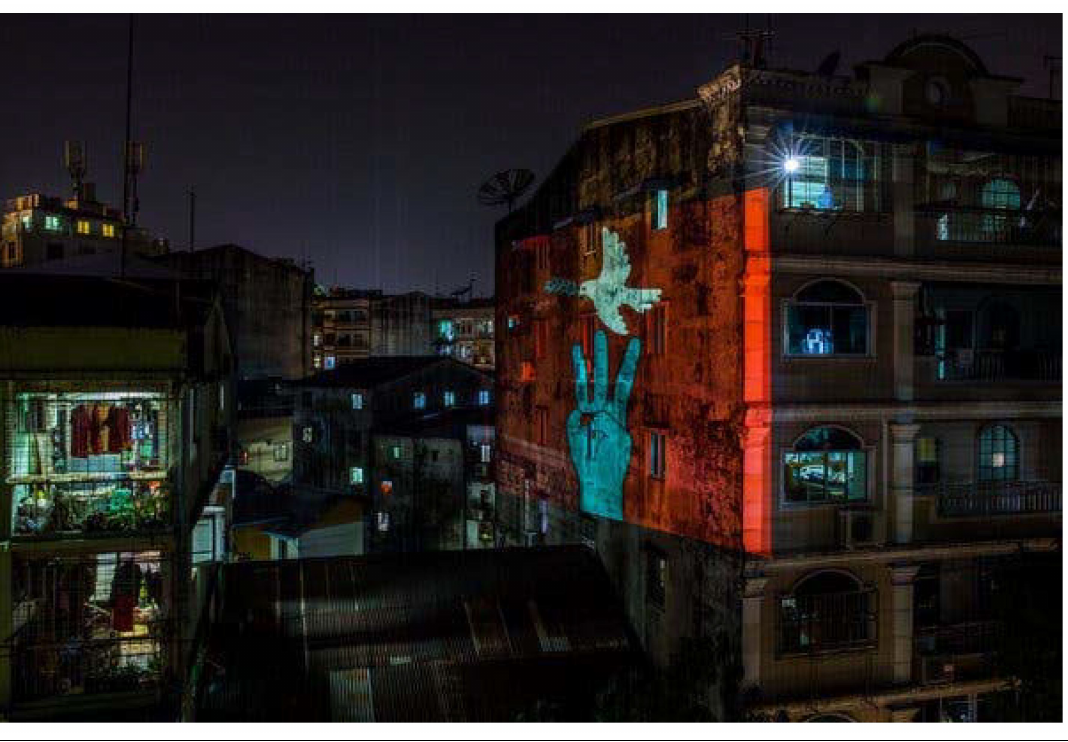
Figure 3 A three-fingered salute and dove are projected onto a building during protests against a military coup in Myanmar in 2021 (Source: Anonymous, The New York Times/Redux,